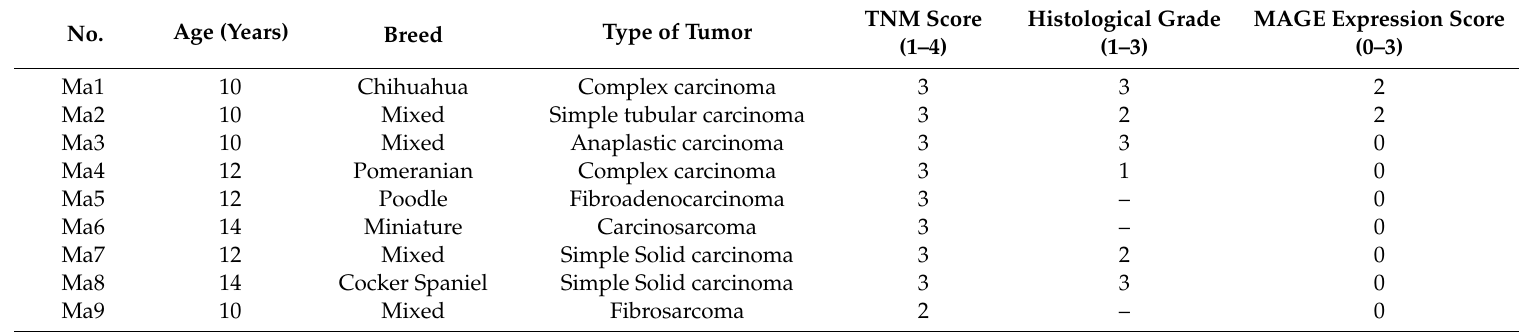
Table 3. Results of canine MAGE antigen recognized human MAb 6C1 in malignant CMT